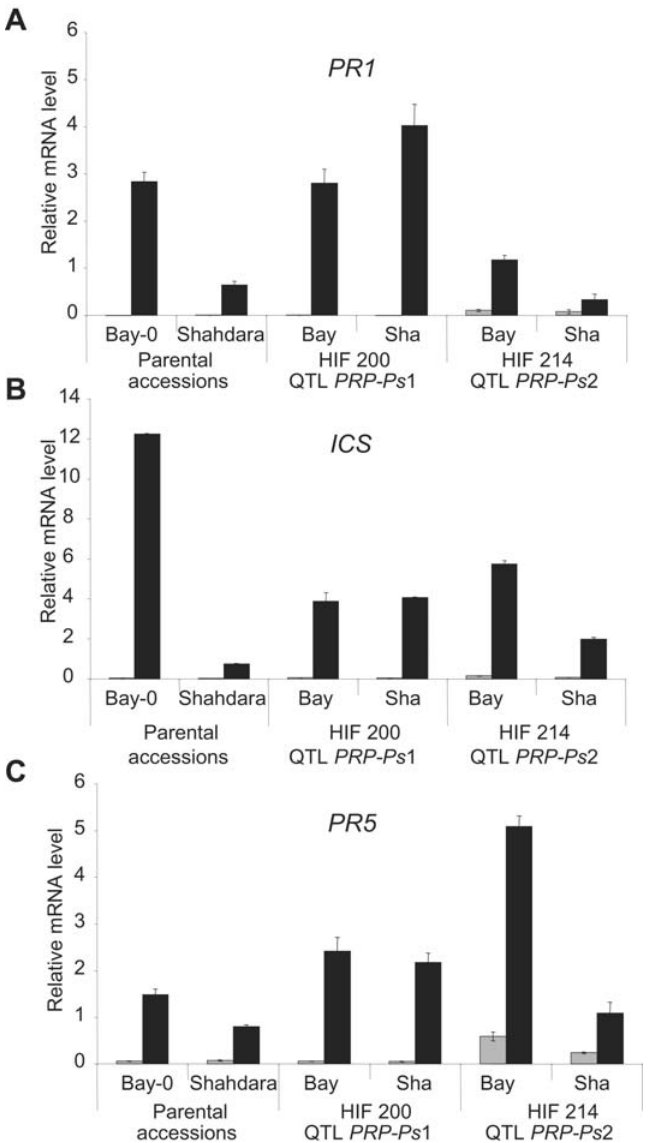
Figure 5. Expression analysis of the defense marker genes PR1 (A), ICS (B) and PR5 (C) in HIFs and parental accessions. The transcript levels were determined by Q-RT-PCR with cDNA generated from leaves before (grey) and after (black) inoculation with Pst DC3000 at 5.10 5 cfu/mL. The expression value of the individual genes was normalized by using the expression level of b -Tubulin4 as an internal standard. Mean mRNA levels of three plants are shown with corresponding standard errors. Similar results were obtained from two biological